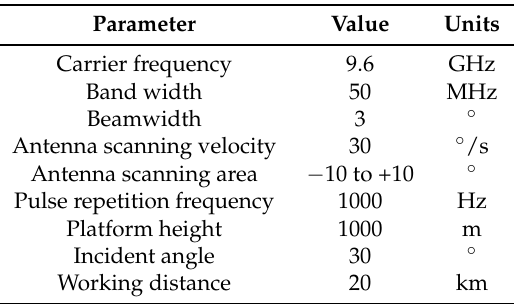
Table 1. Simulation